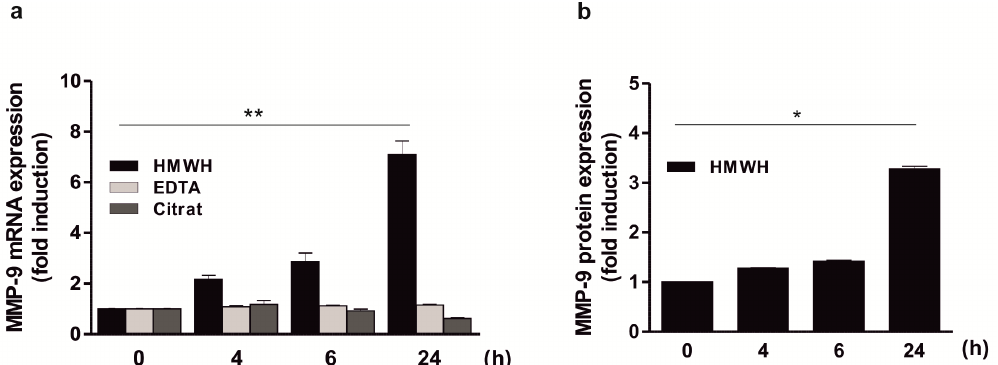
Figure 2. Induction of MMP-9 expression by HMWH in a THP-1, Jurkat, and HT cells containing co-culture. 7 × 10 5 THP-1, Jurkat, and HT cells per well each (i.e., a total of 2.1 × 10 6 cells/well) were starved overnight and then stimulated with 50 IU/well HMWH, 3.2 mg/well EDTA, or 220 µ L/well citrate up to 24 h. MMP-9 mRNA ( a ) and protein ( b ) expression were determined using qPCR (QuantiTect Custom Assay; housekeeping gene: GAPDH) and ELISA (MMP-9 Quantikine Kit); mean ± SD, n = 3 (measured in duplicates). Kruskal–Wallis test, * p ≤ 0.05; ** p ≤